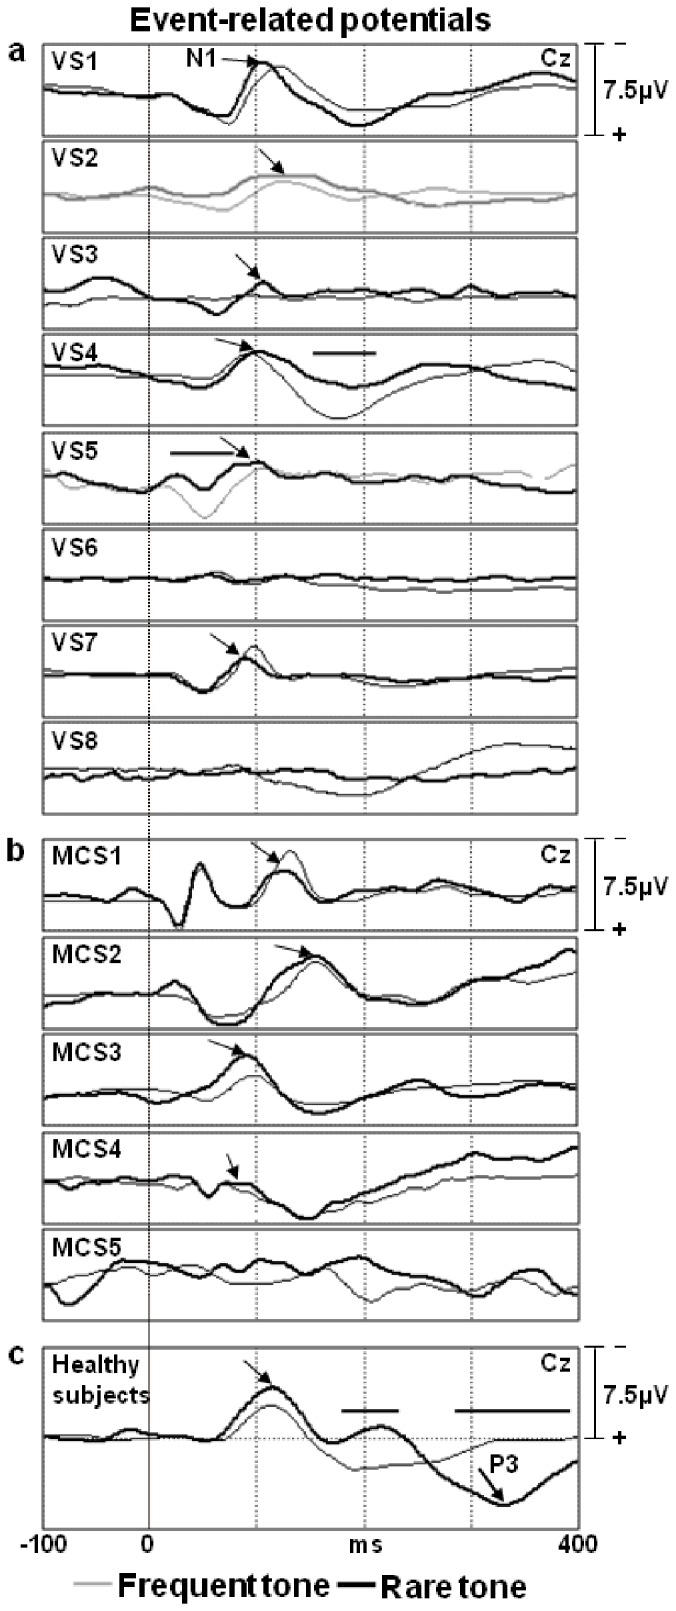
Individual event-related potentials (ERPs) recorded from the Cz electrode to frequent (thin line) and rare (thick line) tones.Panel a: vegetative patients (VS). Panel b: minimally conscious patients (MCS). Panel c: normal control subjects (grand average of 25 individuals). Horizontal segments refer to the time windows where the ERP responses to frequent and rare tones differed significantly (sample-by-sample t-test, p<0.01).